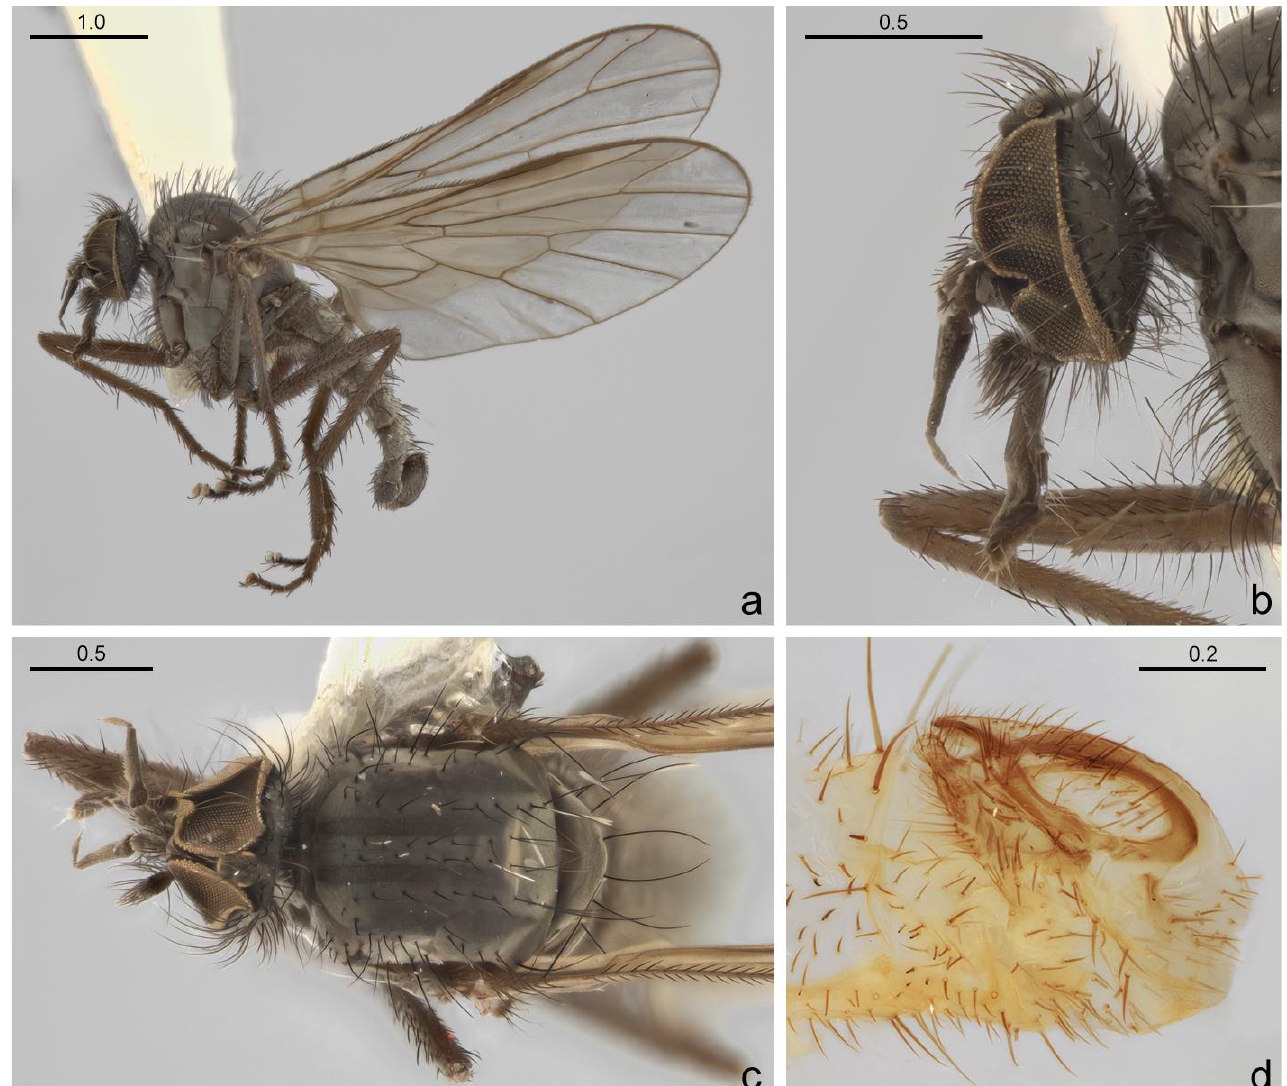
Figure 3. Hilarempis motumaka n. sp.: ( a ) male habitus, left lateral; ( b ) male head, left lateral; ( c ) male head and thorax, anterodorsal; ( d ) male postabdomen, left lateral.